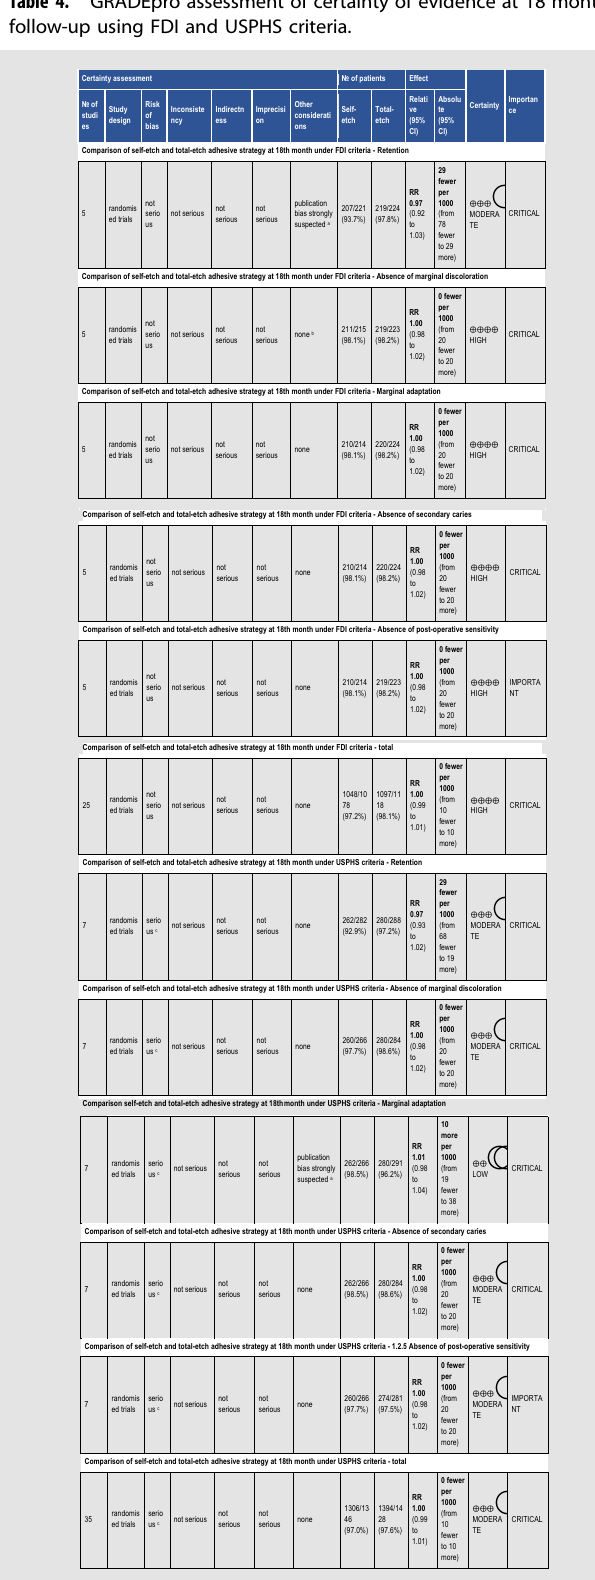
Table 3. Analysis of certainty of